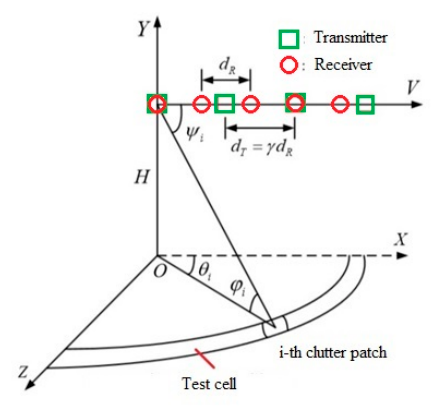
Figure 1. Geometry of the MIMO radar system under consideration.